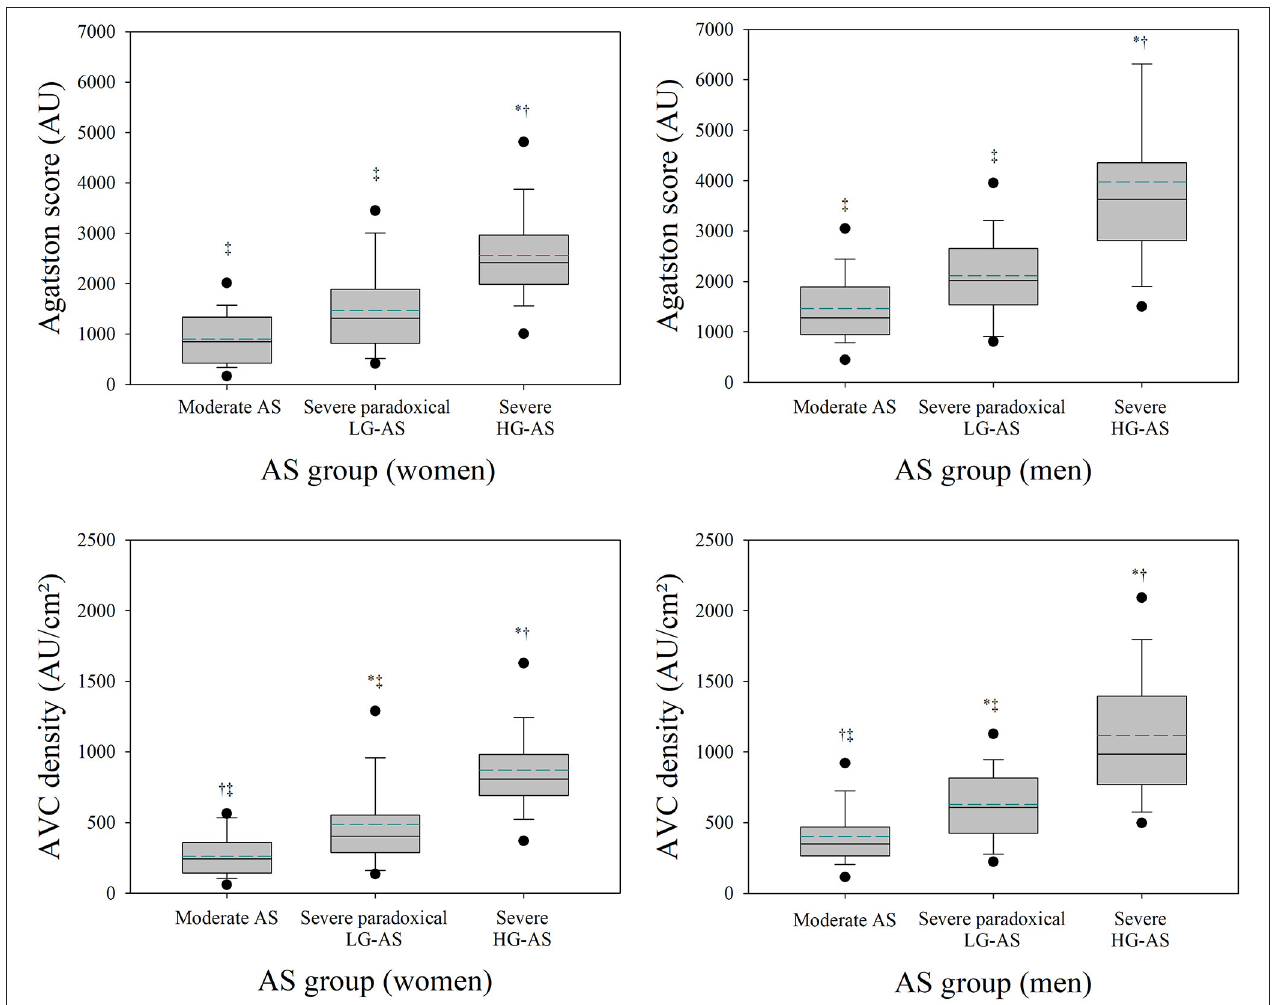
FIGURE 2 | AVC load indices in patients with moderate-to-severe aortic stenosis. Box plots of aortic valve Agatston score (AVC) and AVC density in women (left upper panel) and men (right upper panel) with moderate-to-severe aortic stenosis. The upper and lower edges of the boxes represent the 25th and 75th percentiles. The horizontal line within the boxes represents the median value and the dashed line the mean value. Error bars represent the 95% confidence interval. Pts, patients; AS, aortic stenosis; NF, normal flow; LF, low flow; LG, low gradient; HG, high gradient. * p < 0.05 vs. MAS; † p < 0.05 vs. severe paradoxical LG-AS; ‡ p < 0.05 vs. severe